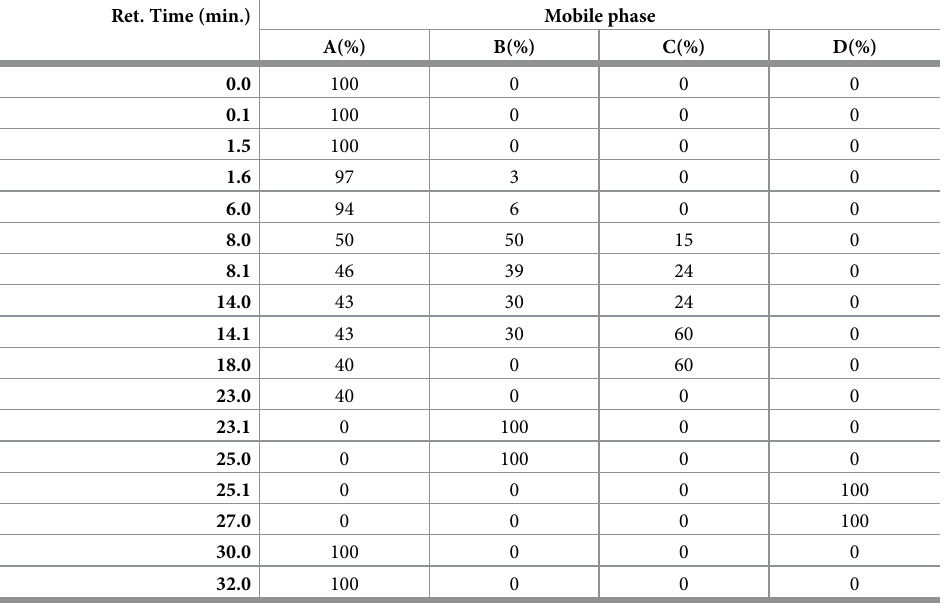
Table 2. Quaternary gradient used during NP-HPLC separation of spat TLE. Mob A: Isooctane:Ethyl Acetate (99.8:0.2); Mob B: Acetone: Ethyl Acetate (2:1) + 25 mM GAA; Mob C: IPA: Water (85:15) + 15mM GAA and 7.5 mM TEA; Mob D: Isopropanol. Ret. Time (min.) Mobile